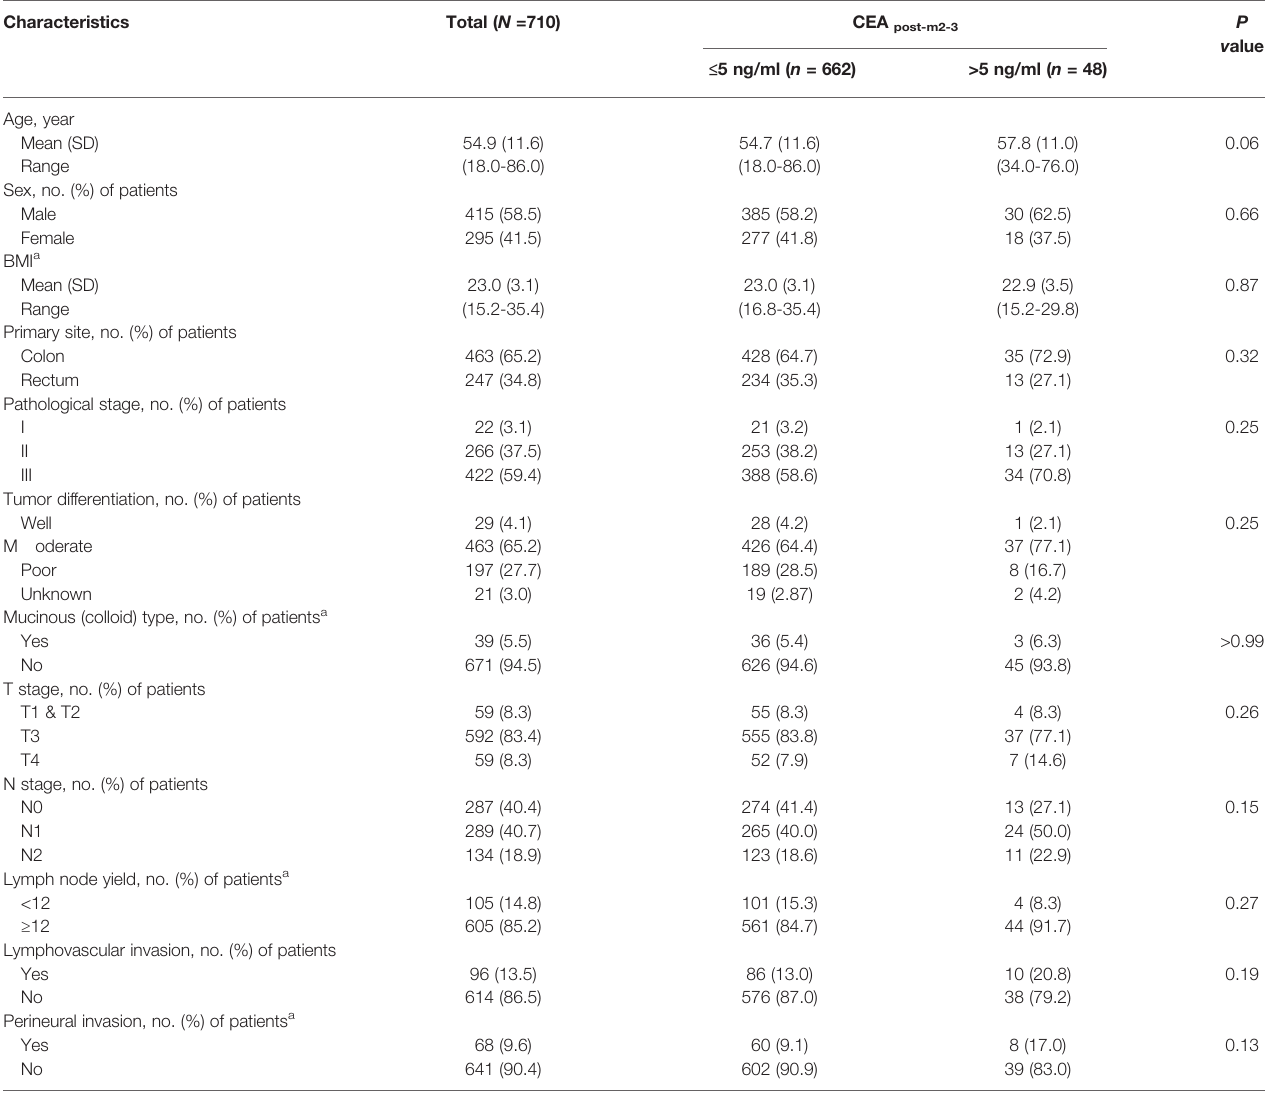
TABLE 1 | Demographic and Clinicopathological Characteristics of Primary Analysis Population.